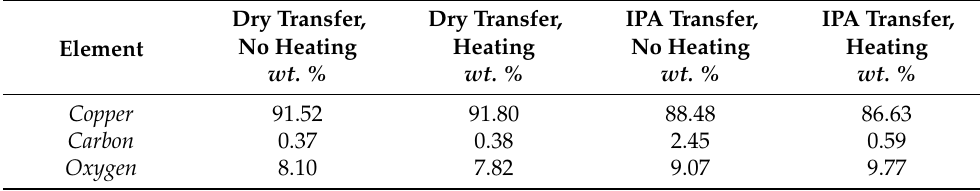
Table 1. TEM-EDS analysis of Cu 2 O samples.